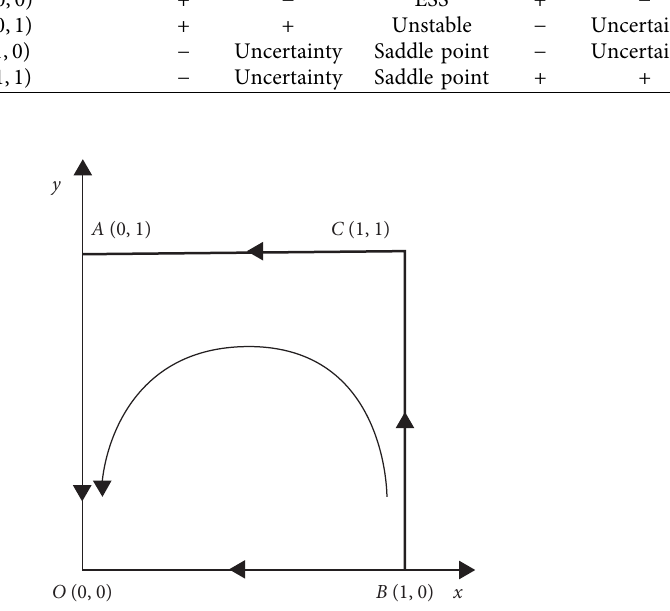
Figure 2: Dynamic evolution of the system in Scenario 2. Figure 3: Dynamic evolution of the system in Scenario